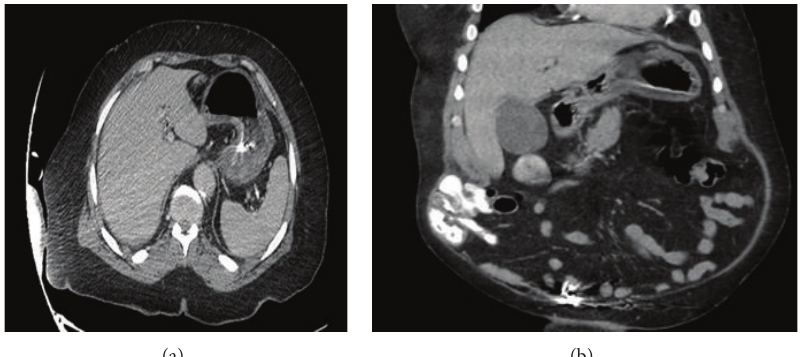
Figure 2: Contrast enhanced CT scan of the abdomen (48 hours after presentation) showing resolution of gas in the wall of the stomach, portal veins, and